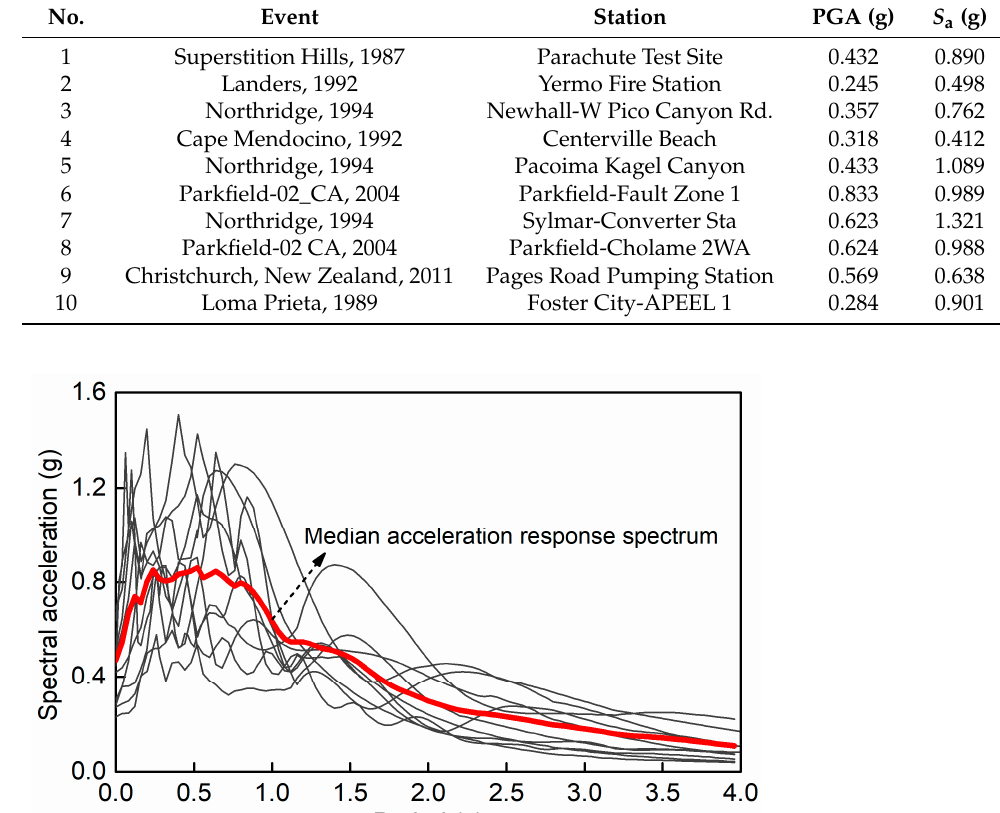
Table 4. Ground motion records for dynamic time-history analysis.